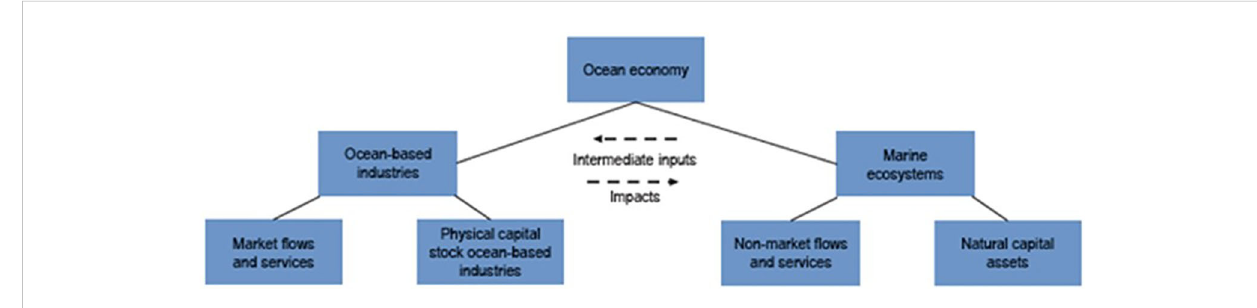
FIGURE 2 Ocean economy according to the OECD. Source: OECD